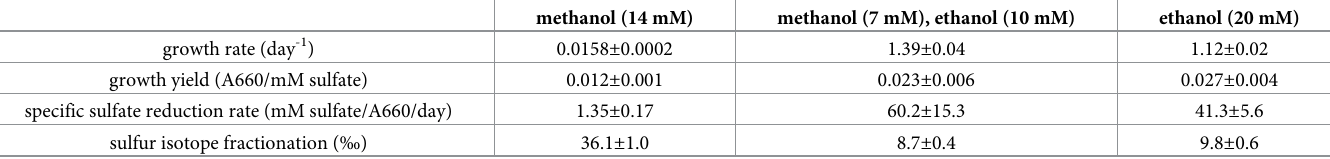
Table 2. Comparison of growth parameters and sulfur isotope fractionations in D . carbinolicus batch cultures containing methanol and/or ethanol as electron